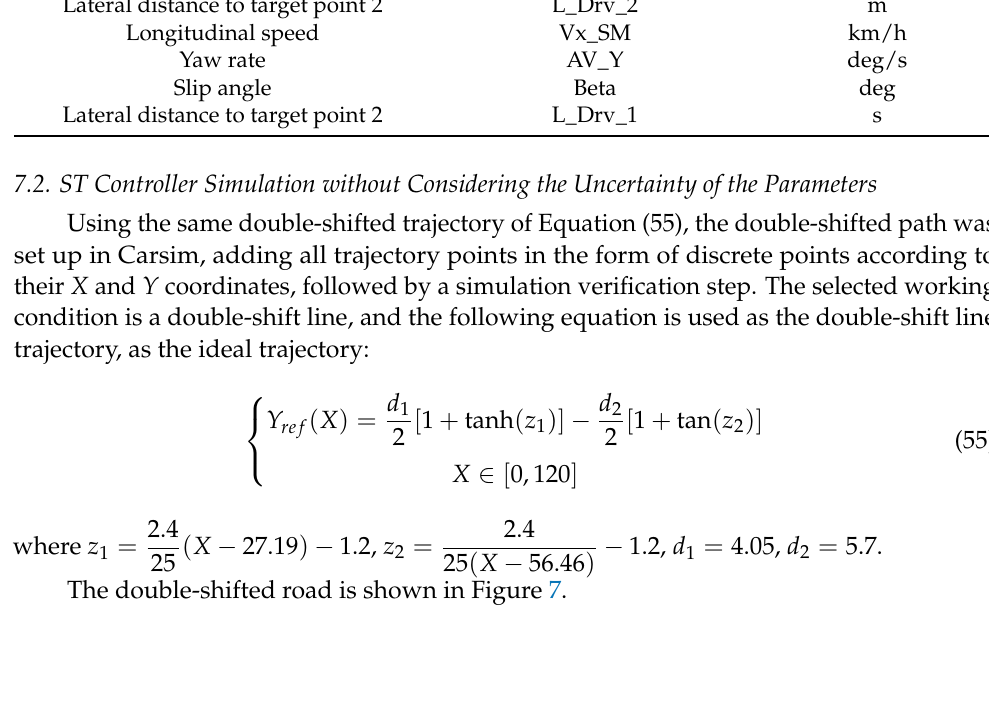
Figure 6. Combined Carsim-Simulink simulation model.